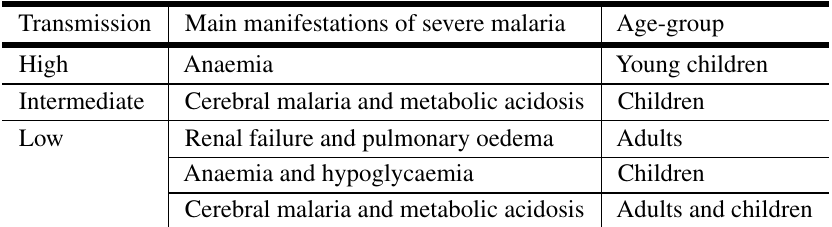
Main manifestations of severe malaria as related to age-group in areas of different malaria